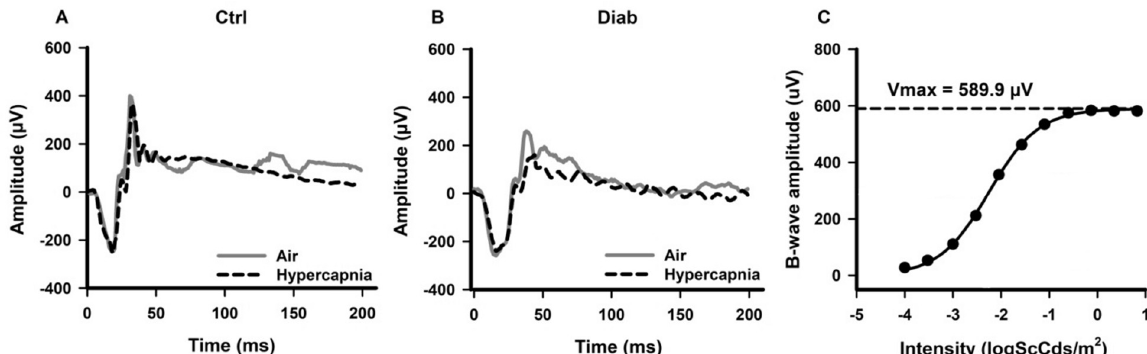
Fig 1. Examples of scotopic ERG waveforms recorded from a Ctrl mouse (A) and a Diab mouse (B) under regular room air condition (solid gray lines) and under hypercapnia (dashed black lines) after a short flash of -0.1 log Sc Cd � s/m 2 . An example of ERG b-wave intensity-response from a Ctrl mouse is shown with estimated Vmax from a Naka-Rushton fit (C)